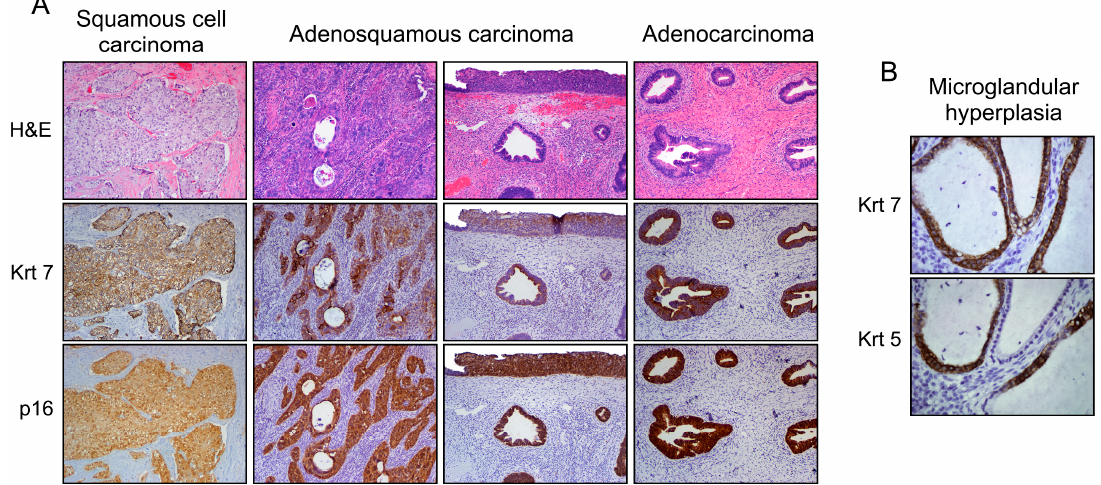
Figure 3. Phenotypic variants among cervical malignant epithelial tumors ( A ). Note the Krt7 immunoreactivity displayed by squamous, adenosquamous (blended or individuated/adjacent lesions), and columnar neoplasms supporting their similar cell of origin (SC junction); and ( B ) under benign conditions (i.e., microglandular hyperplasia), a mixed phenotype can also be observed. Note the Krt5 (squamous biomarker) expression in Krt7-positive cuboidal cells without evidence of reserve cells.